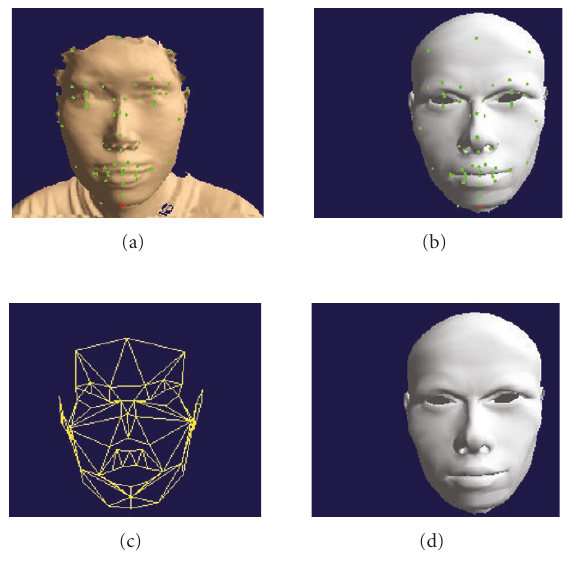
Figure 4: Initial adaption using approach no.1 with subset of MPEG-4 feature points. (a) The input scanned data; (b) the adapted head model; (c) the initial feature mesh; (d) the head model for test in iterative